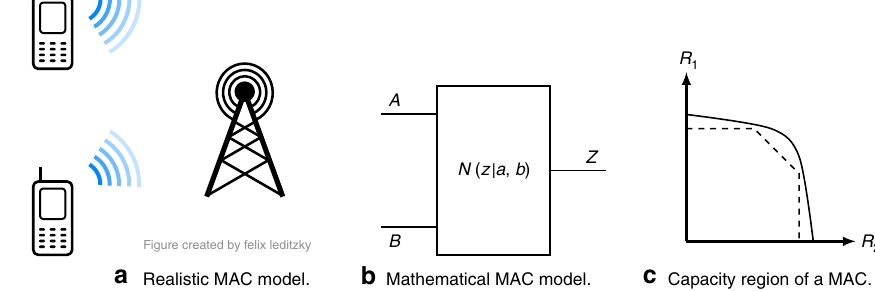
Fig. 1 Multiple access channels. a Realistic scenario of a multiple access channel (MAC), in which two cell phones send data to a cell tower. b Mathematical model of a MAC N , characterized by fi nite input alphabets A and B , an output alphabet Z , and a conditional probability distribution N ( z ∣ a , b ) for a 2 A ; b 2 B ; z 2 Z . The random variables corresponding to the senders and the receiver are denoted by A , B , and Z , respectively. c A typical capacity region of a MAC (solid line), together with an achievable pentagonal region for a fi xed input distribution (dashed